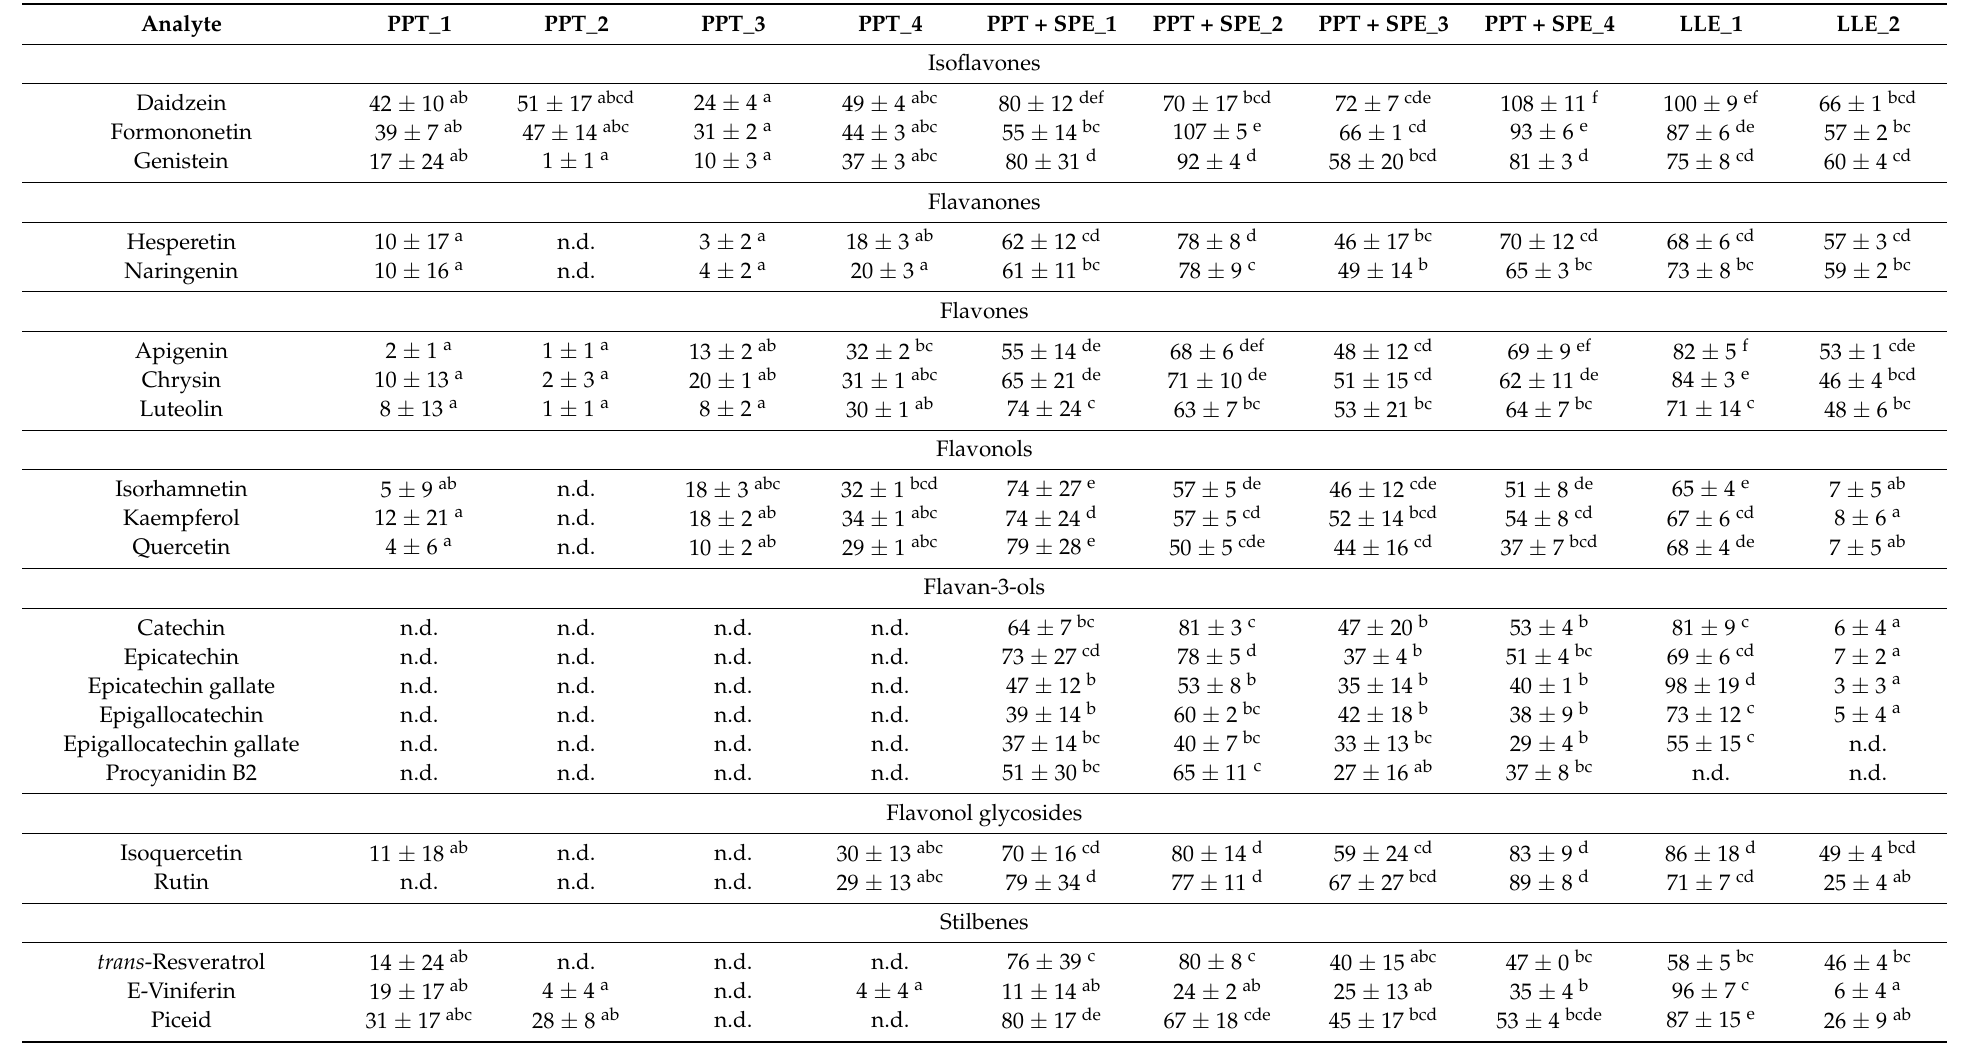
Table 2. Recovery (%R) data of the studied polar phenols after testing ten different sample preparation methods for serum (n = 3). Analyte PPT_1 PPT_2 PPT_3 PPT_4 PPT + SPE_1